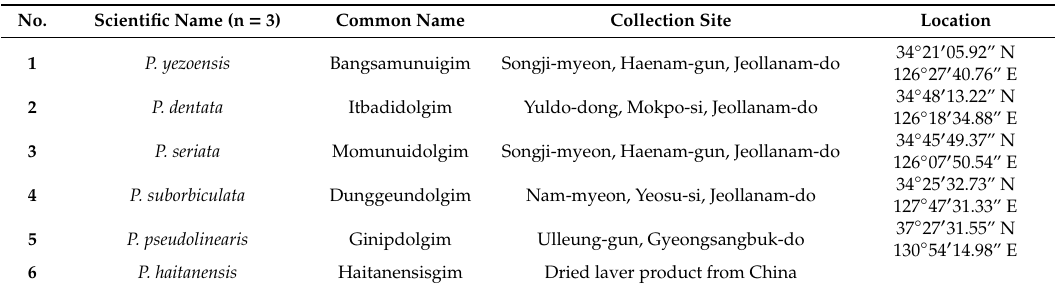
Table 2. Pyropia samples used in this